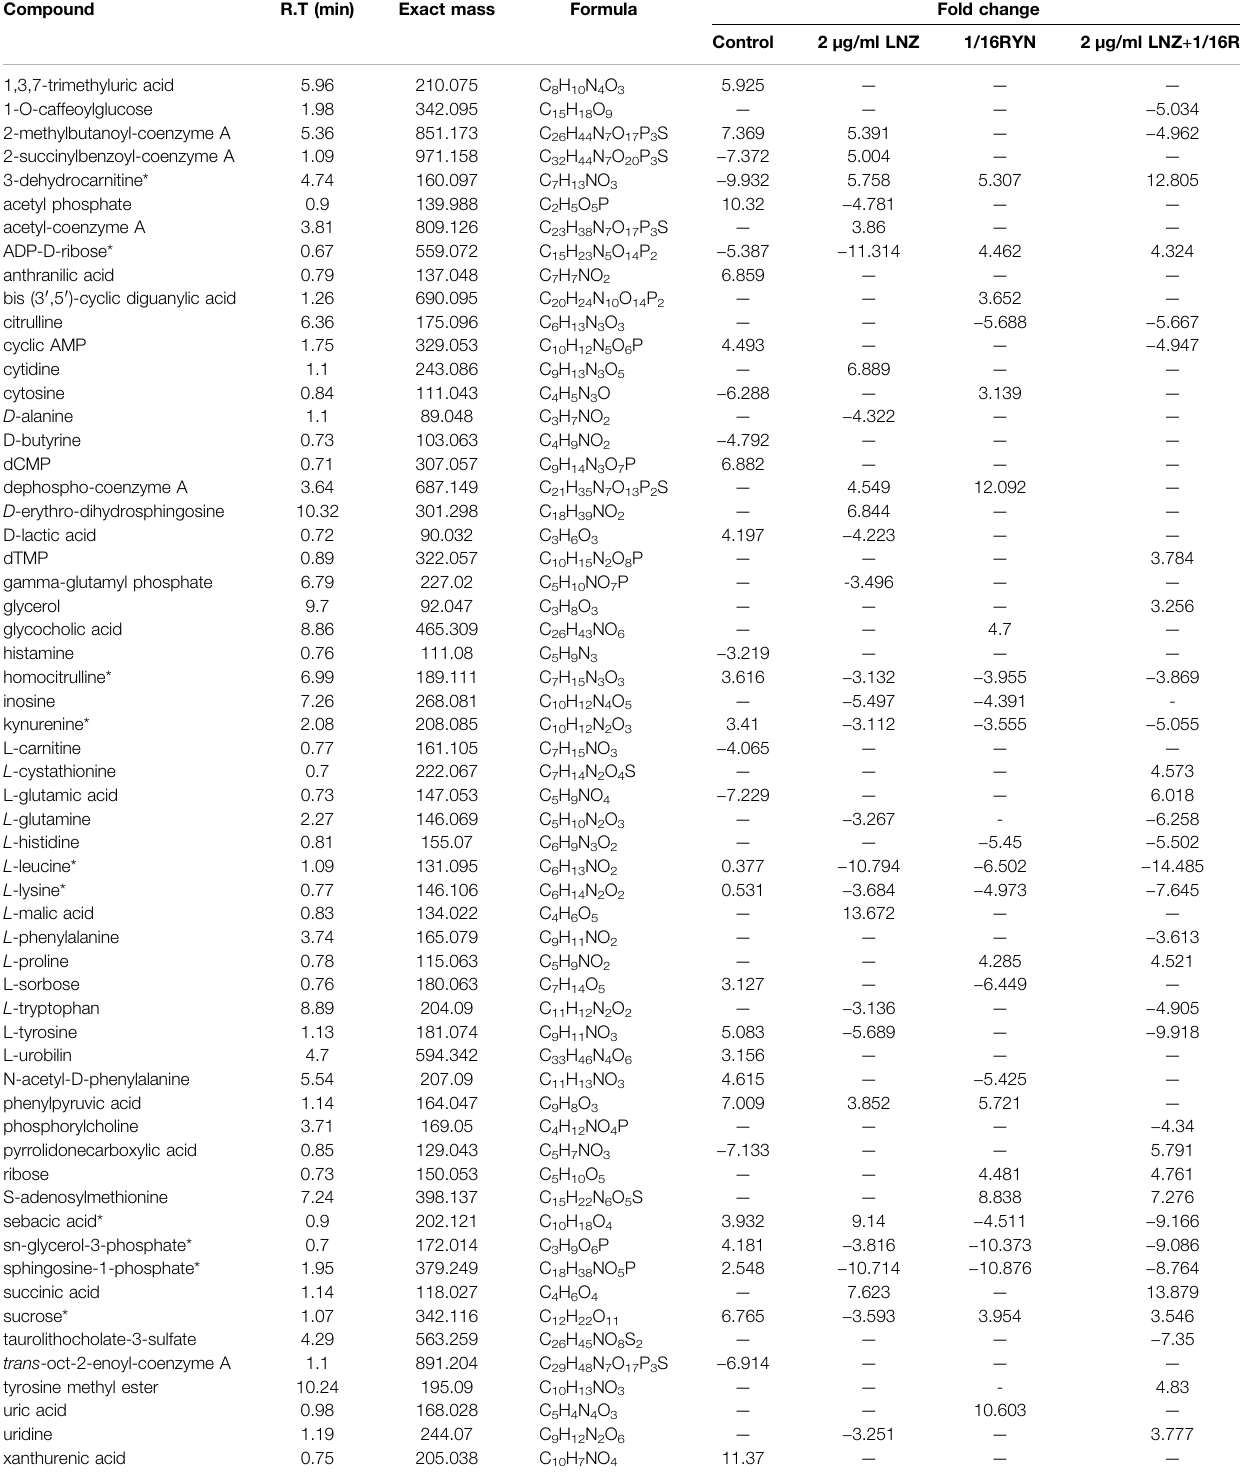
TABLE 3 | Different metabolites in each